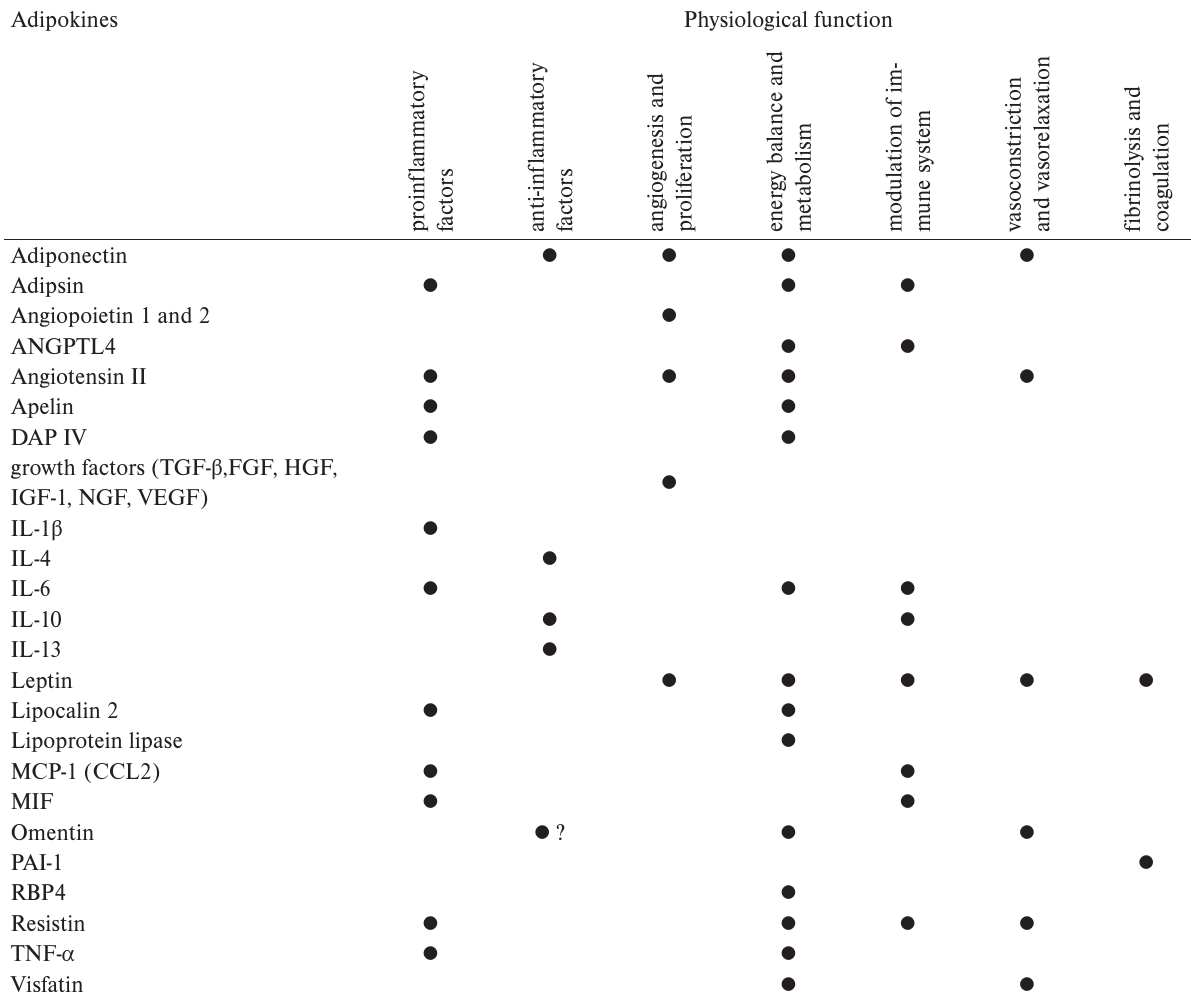
Table 1. Physiological functions of selected substances secreted by white adipose tissue. Adipokines Physiological